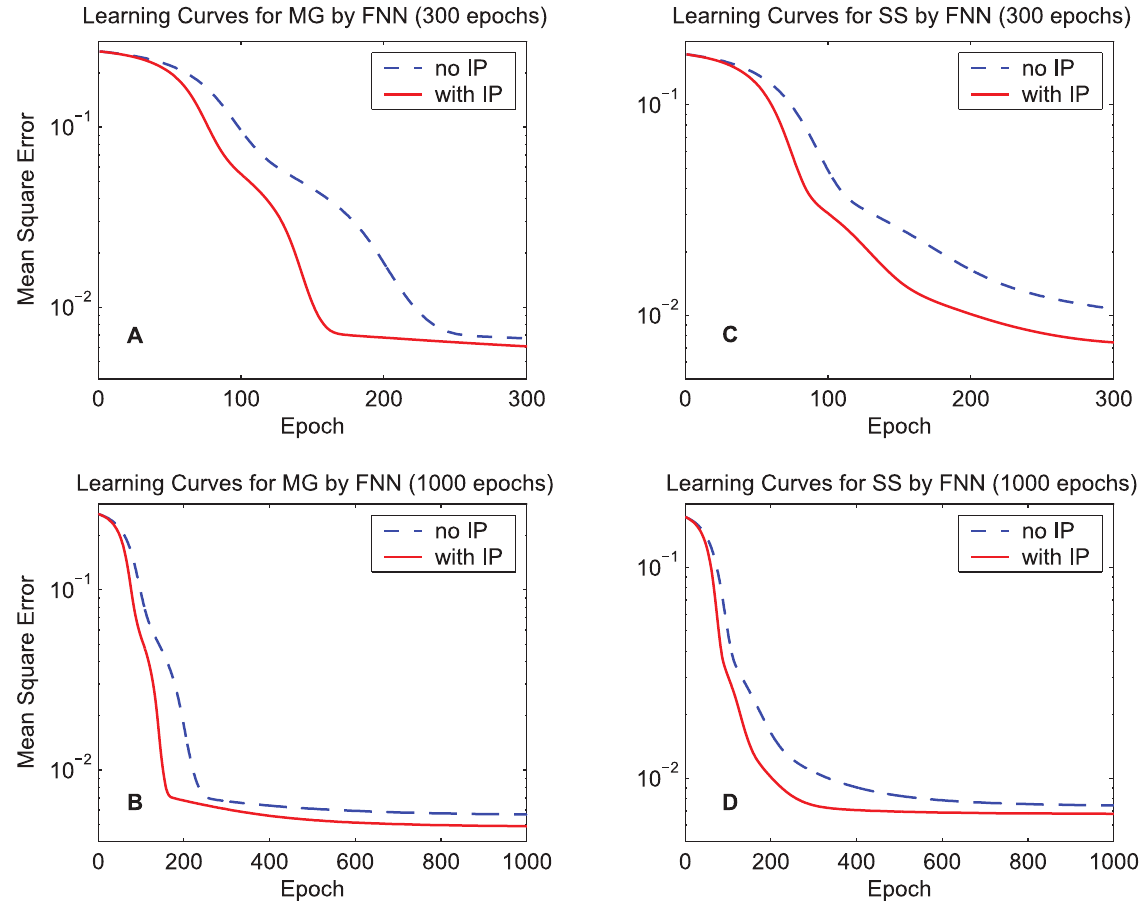
Figure 4. Learning curves of the mean square error by the FNN. The dashed lines denote the learning curves of the MEE algorithm, and the solid lines denote the learning curves of the synergistic algorithm. (A) 300-epoch learning curves for the training data set ‘‘MG’’. (B) 1000-epoch learning curves of ‘‘MG’’. (C) 300-epoch learning curves for the training data set ‘‘SS’’. (D) 1000-epoch learning curves of ‘‘SS’’.